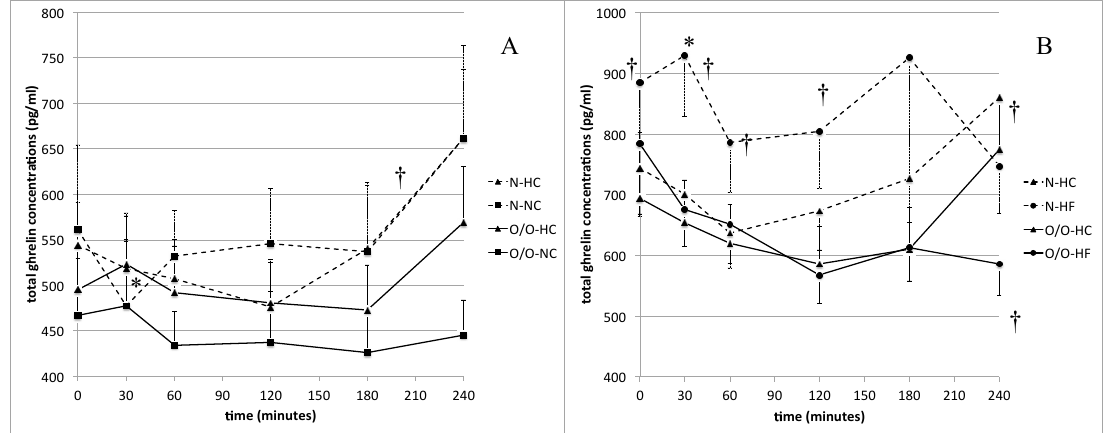
Figure 3. ( A ) Total ghrelin concentrations (ng/mL) in men with normal body weight (N, the broken line) and overweight/obese people (O/O, the solid line) in fasting state (time 0 min) and after consumption (time 30–240 min) of a high carbohydrate meal (HC) and a normal carbohydrate meal (NC). The results are presented as mean values ± SE. * The comparison between study groups N and O/O, p < 0.05. † The comparison between meals HC and NC, p < 0.05. ( B ). Total ghrelin concentrations (ng/mL) in men with normal body weight (N, the broken line) and overweight/obese people (O/O, the solid line) in fasting state (time 0 min) and after consumption (time 30–240 min) of a high carbohydrate meal (HC) and a high fat meal (HF). The results are presented as mean values ± SE. * The comparison between study groups N and O/O, p < 0.05. † The comparison between meals HC and HF, p < 0.05.